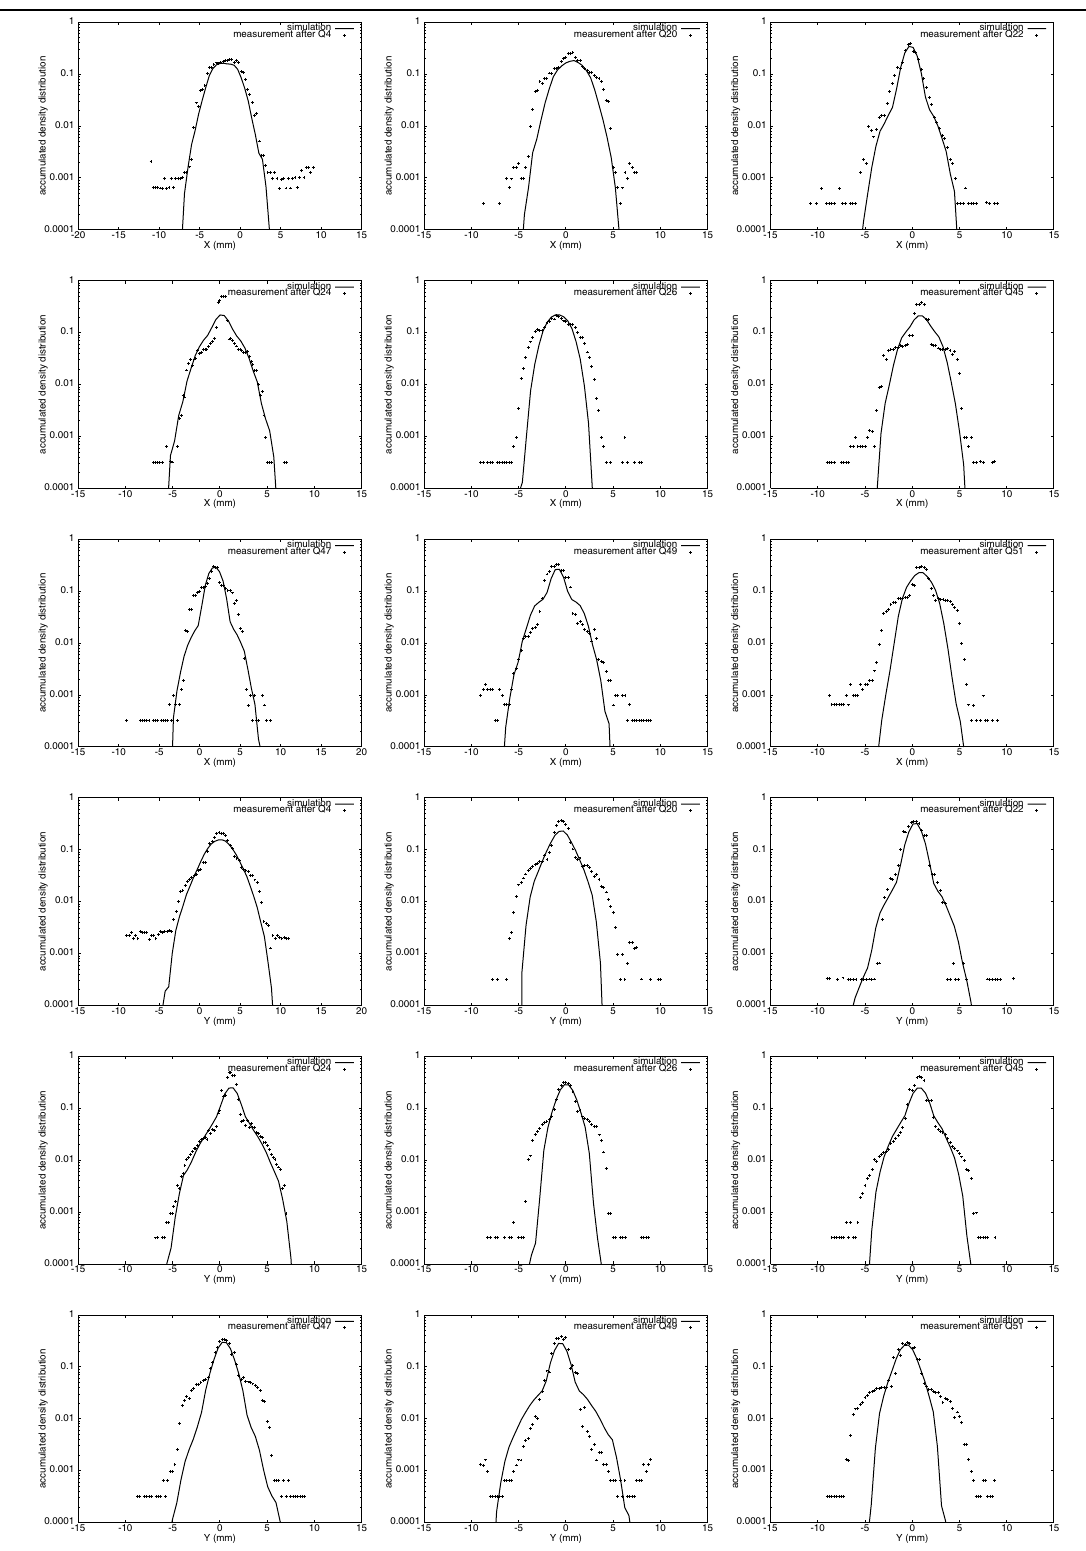
FIG. 9. X and y density distribution from simulation using initial LEBT/RFQ output distribution and from measurements at 75 mA and mismatch factor of 1.5. The first nine plots correspond to the nine x profiles and the second nine plots correspond to the nine y